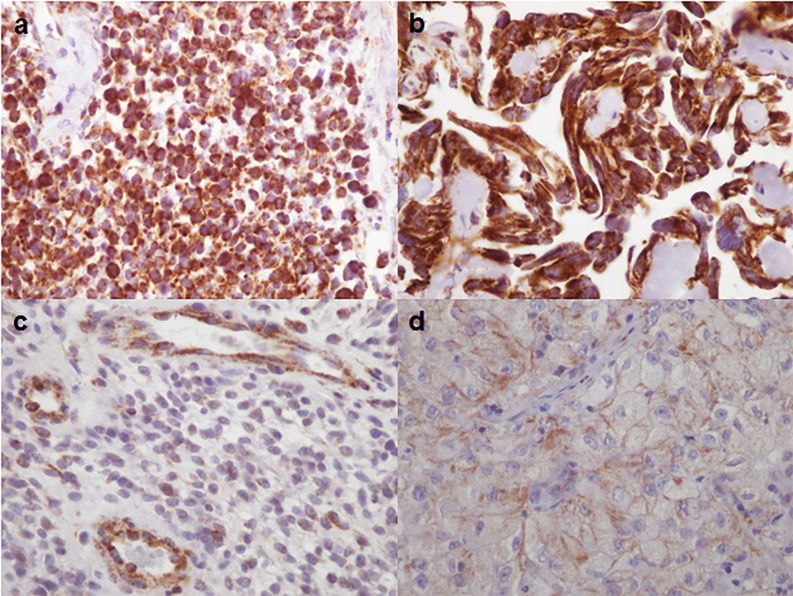
LAT1 immunolabelling (x400).Diffuse and strong LAT1 expression in a small cell glioblastoma (a) and in a metastasis of ovary adenocarcinoma (b). Weak LAT1 expression in a glioblastoma (c) and in a metastasis of lung adenocarcinoma (d). Note LAT1 expression in endothelial cells (c).